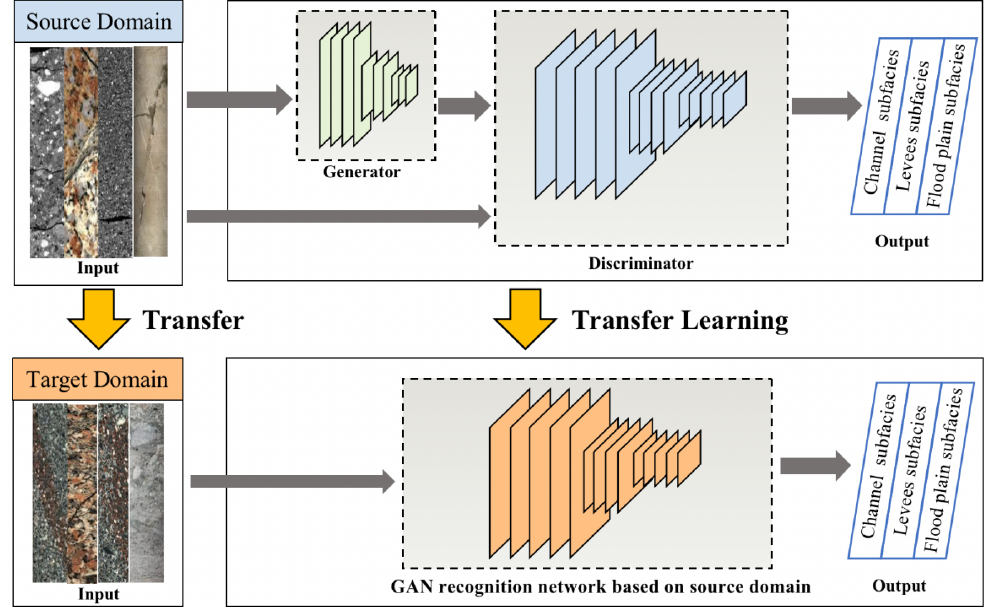
Figure 2. Adversarial transfer learning framework